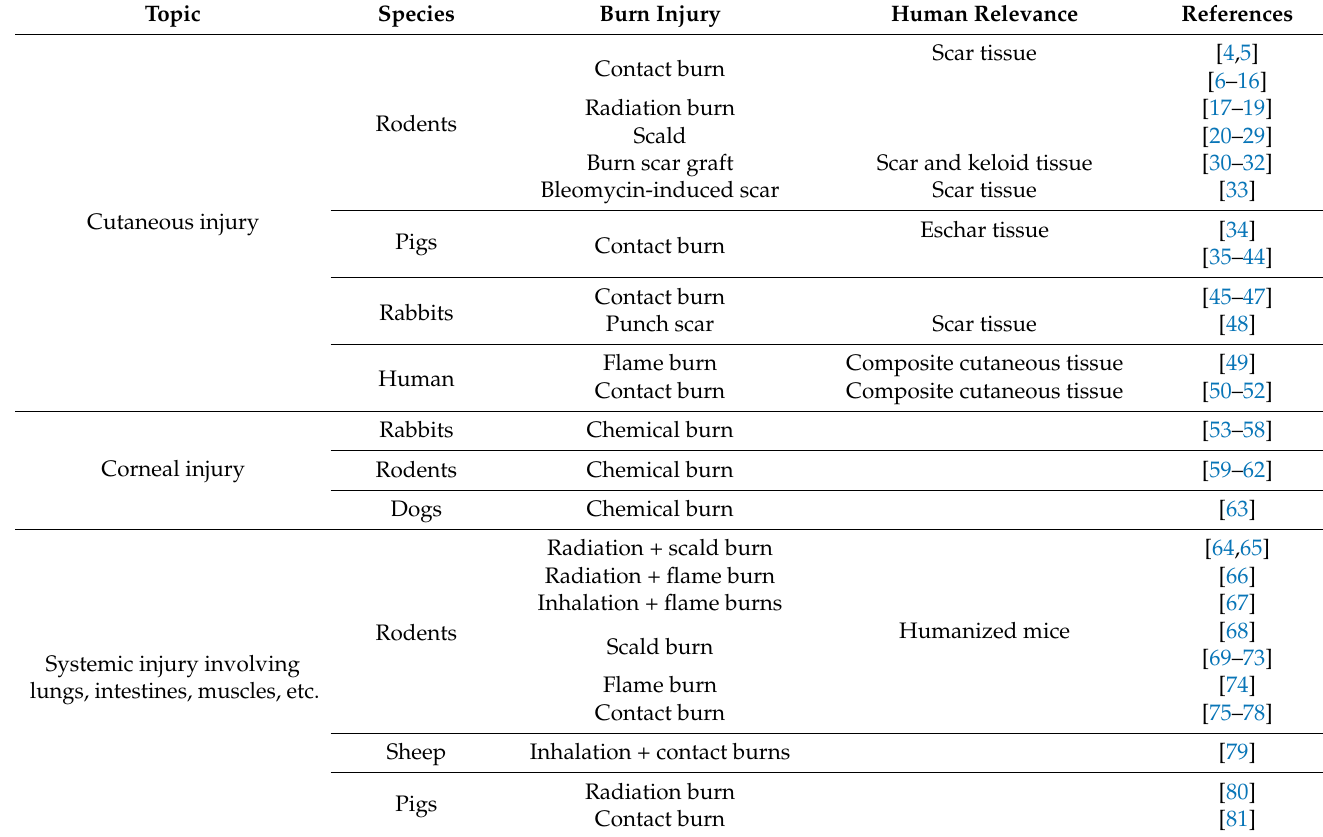
Table 1. Experimental burn models utilized since